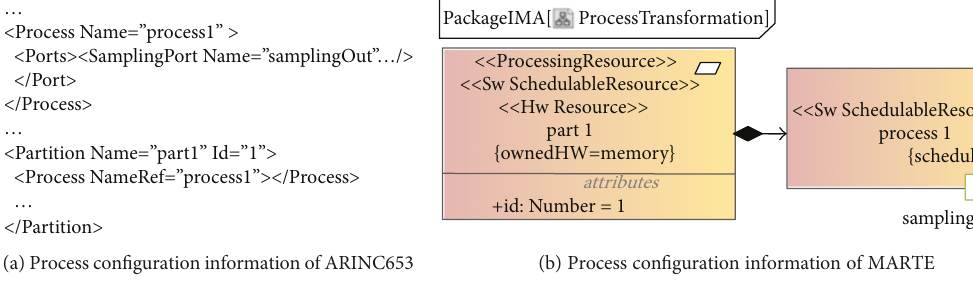
Figure 5: Process con fi guration transformation from ARINC653 to MARTE. Table 5: Health monitoring transformation rules. ARINC653